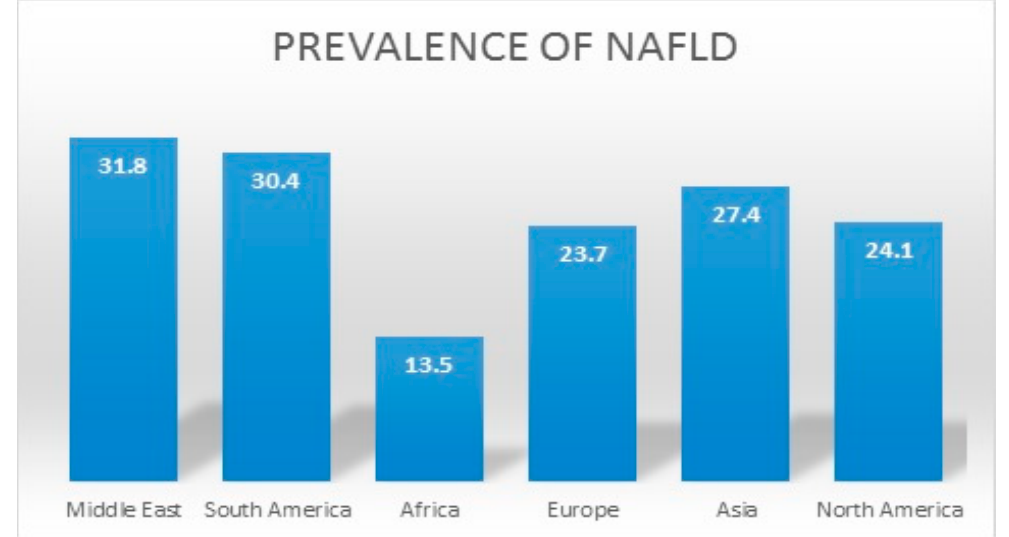
Figure 1. Prevalence of nonalcoholic fatty liver disease (NAFLD) across the world [4].